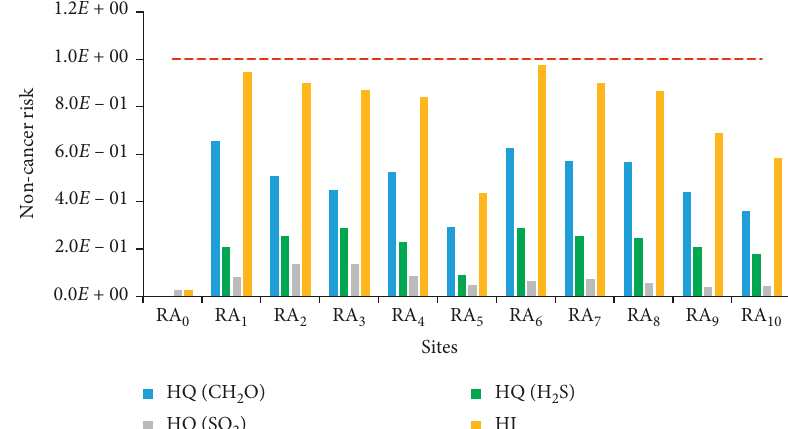
Figure 2: Non-cancer risks at the monitoring sites (the non-cancer risks of CH 2 O and H 2 S at RA0 were not calculated because they were not detected at that site; the horizontal line represents the admissible level of non-cancer risk [42,